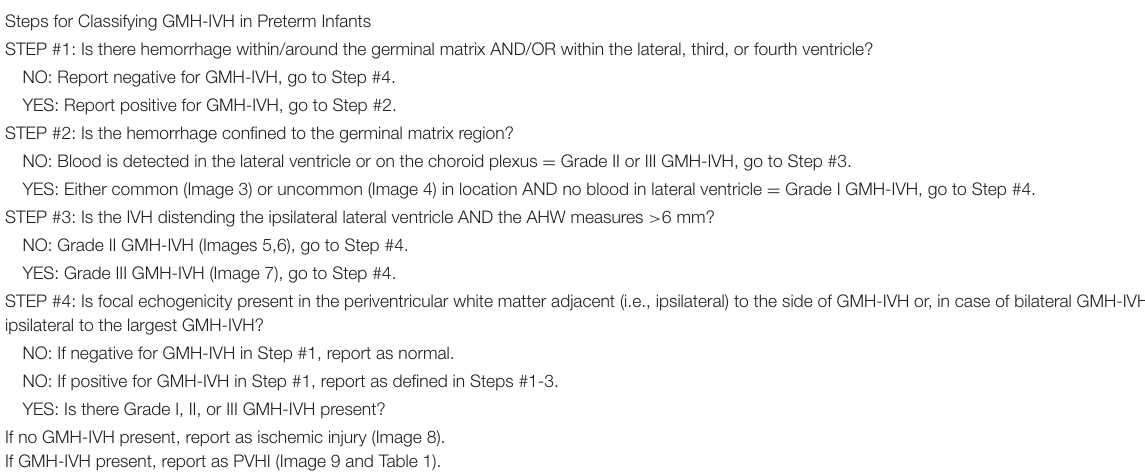
TABLE 1 | Steps for classifying GMH-IVH in preterm infants ( Figures 3 – 9 ). Steps for Classifying GMH-IVH in Preterm Infants